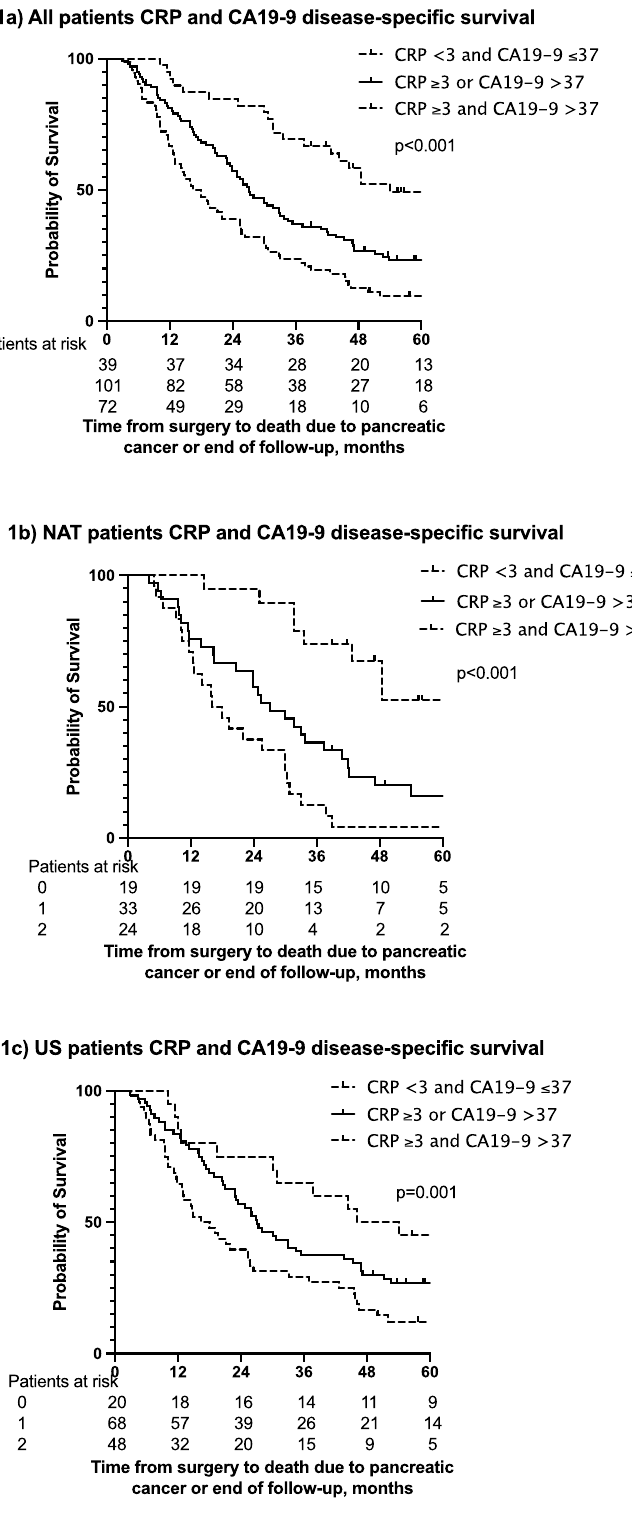
Figure 1. ( a ) Disease-specific survival (DSS) for all patients according to CRP and CA19-9 levels. Median DSS were 54 months (m) (95% CI –), 27 m (95% CI 22–32 m), and 16 m (95% CI 12–21 m). The area under the receiver operation characteristic (ROC) curve at 5 years was 0.686 (95% CI 0.597–0.776) and the overall concordance score was 0.690 (95% CI 0.636–0.745). ( b ) DSS for NAT patients according to CRP and CA19-9 levels. The median DSS for NAT patients with low CRP and CA19-9 has not been reached yet. Median survival for those with either above the cut-off value was 27 m (95% CI 18–36 m) and for those with both above the cut- off value 16 m (95% CI 10–22 m). ( c ) DSS for US patients according to CRP and CA19-9 levels. The median DSS were 46 m (95% CI 25–67 m), 27 m (95% CI 21–33 m), and 16 m (95% CI 11–22